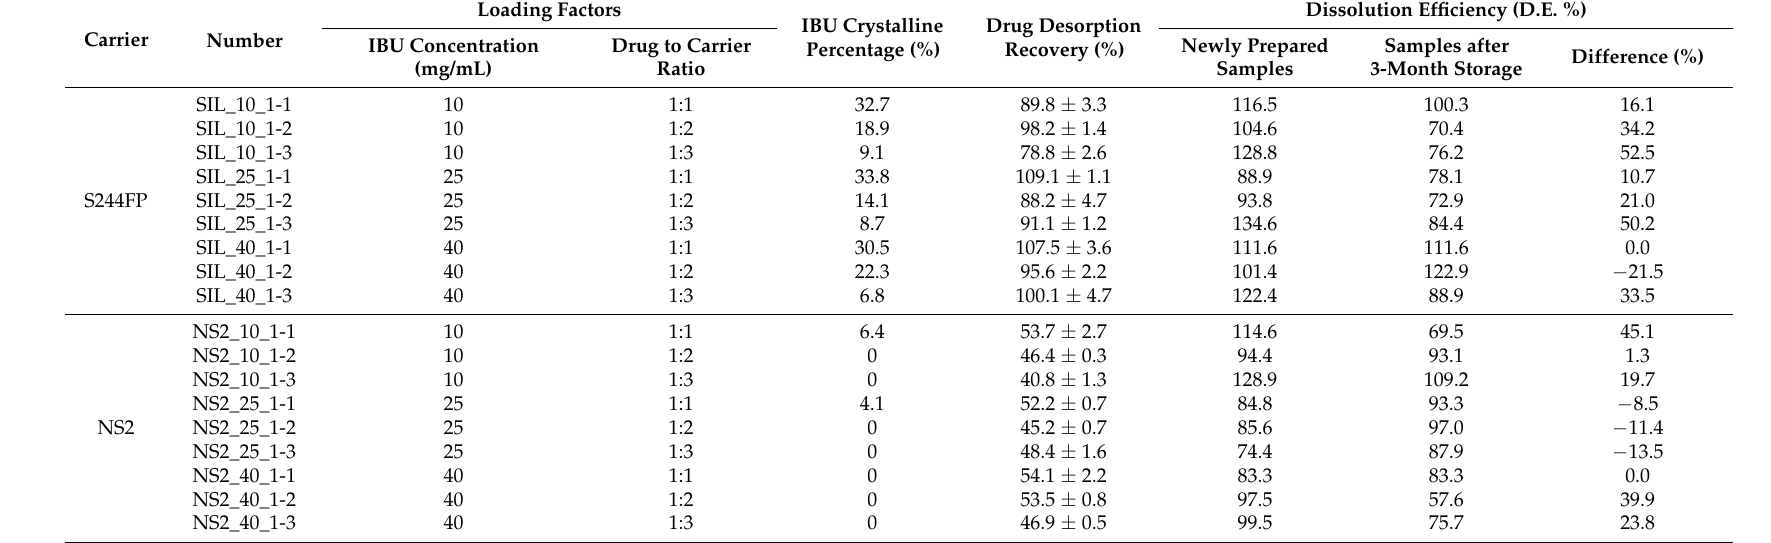
Table 1. Experimental design and characterization. IBU: Ibuprofen; S244FP: Syloid ® 244FP; NS2: Neusilin ®